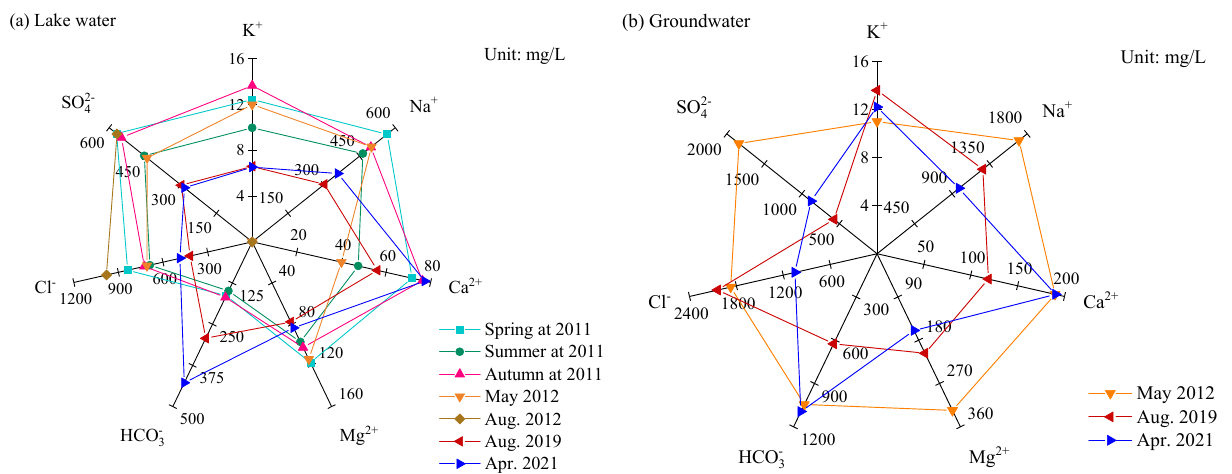
Figure 6. Temporal changes in the hydrochemical indices in ( a ) lake water and ( b ) groundwater before and after the water diversion. The 2011 data are from [35]; the 2012 data are from [36]; and the 2019 data are from [37,31].